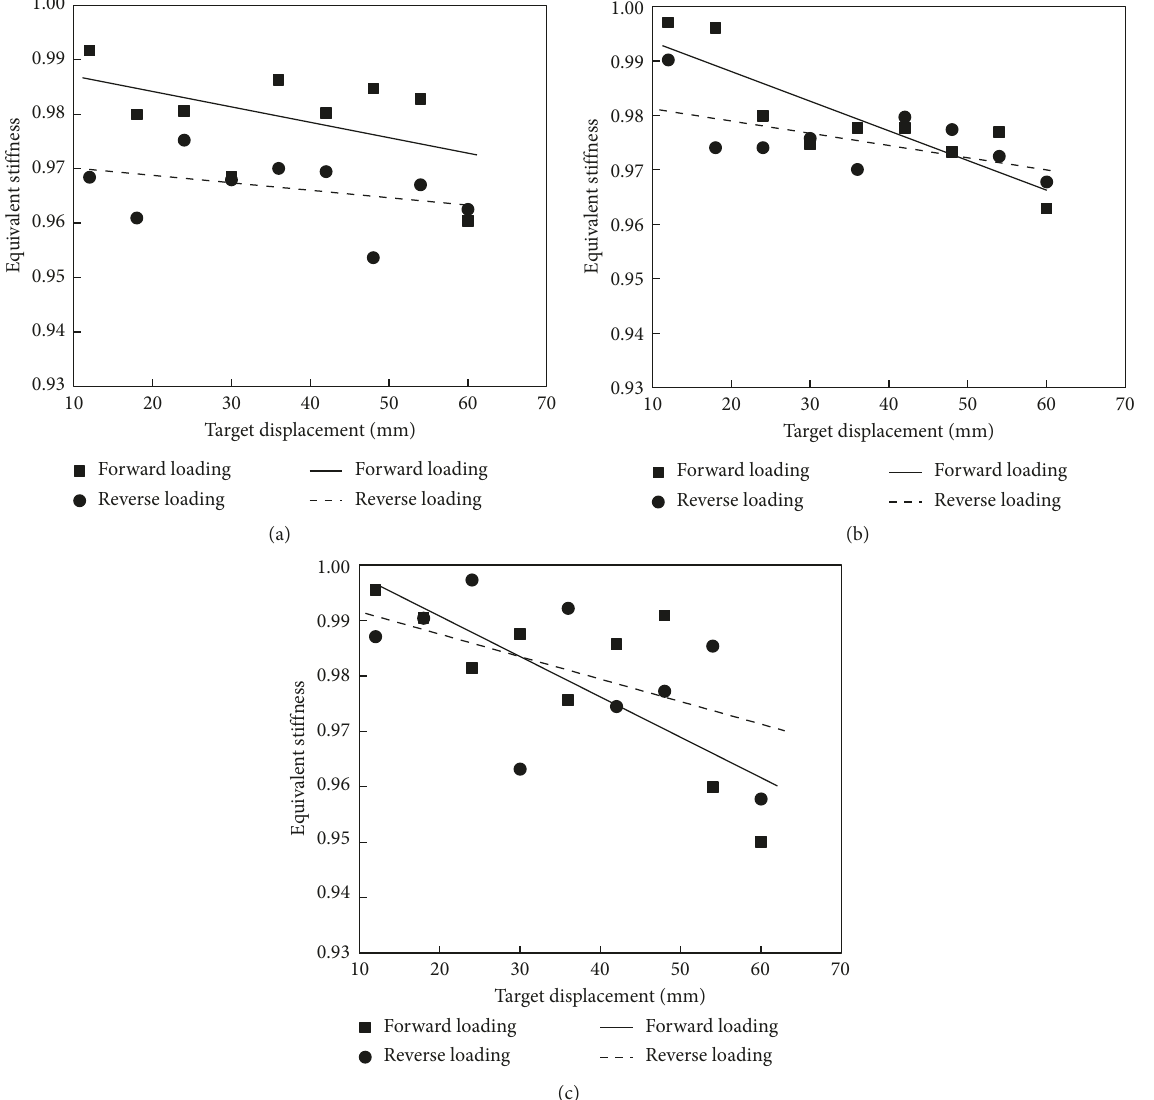
Figure 10: Degeneration loading loops of specimens. (a) Specimen DWHP-1, (b) specimen DWHP-2, and (c) specimen